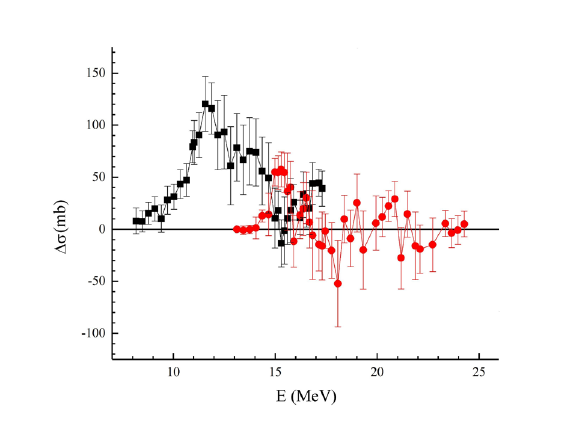
σ exp between the evaluated Figure 3. Di ff erences ∆ σ = σ e v al − [10] and the experimental cross sections for 181 Ta [21]: squares for reaction ( γ, 1 n ), circles – ( γ, 2 n ). Table 2. Integrated cross sections σ int (in MeV mb) obtained up to energy E int = 26.2 MeV cross sections.